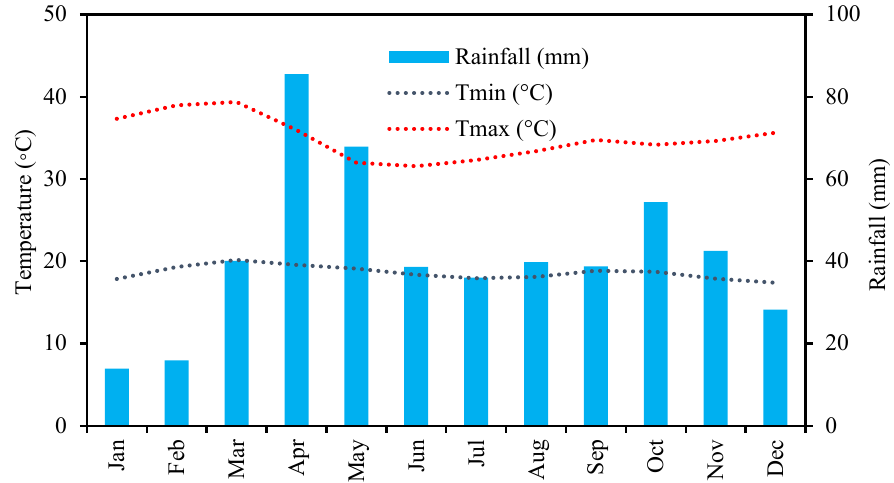
Figure 2. Monthly mean minimum and maximum temperatures, as well as monthly mean rainfall records, are based on observations from 1981 to 2020.